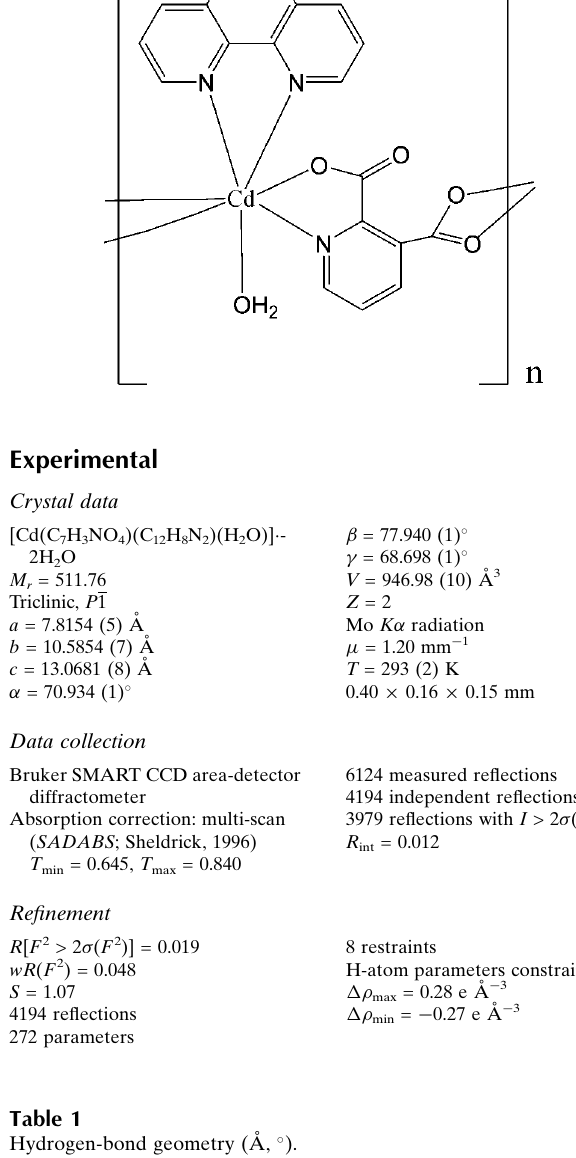
6124 measured reflections 4194 independent reflections 3979 reflections with I > 2 (cid:1) ( I ) R